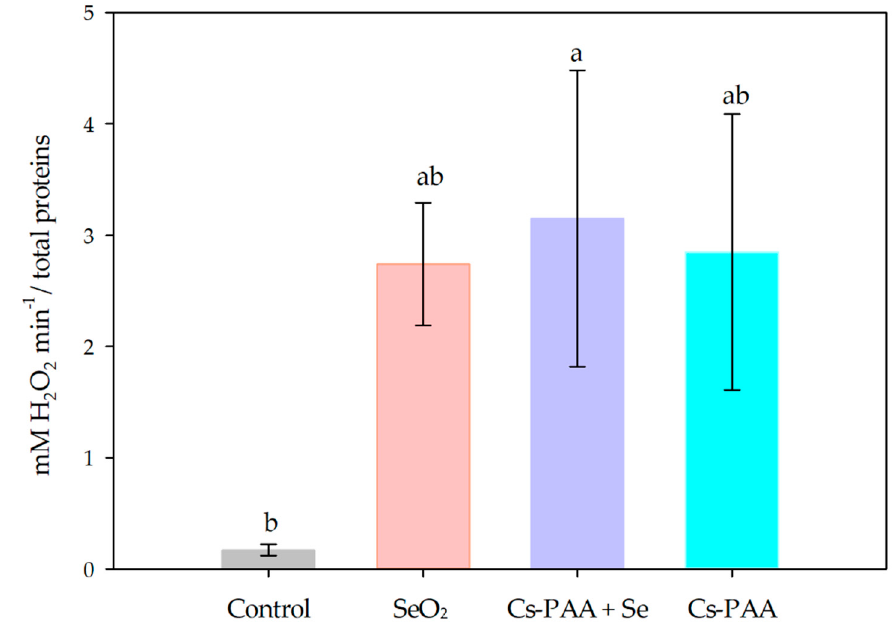
Figure 1. Means comparison of the enzymatic activity of catalase. Means with the same letter are statistically equal (LSD, p ≤ 0.05). Bars represent standard error.